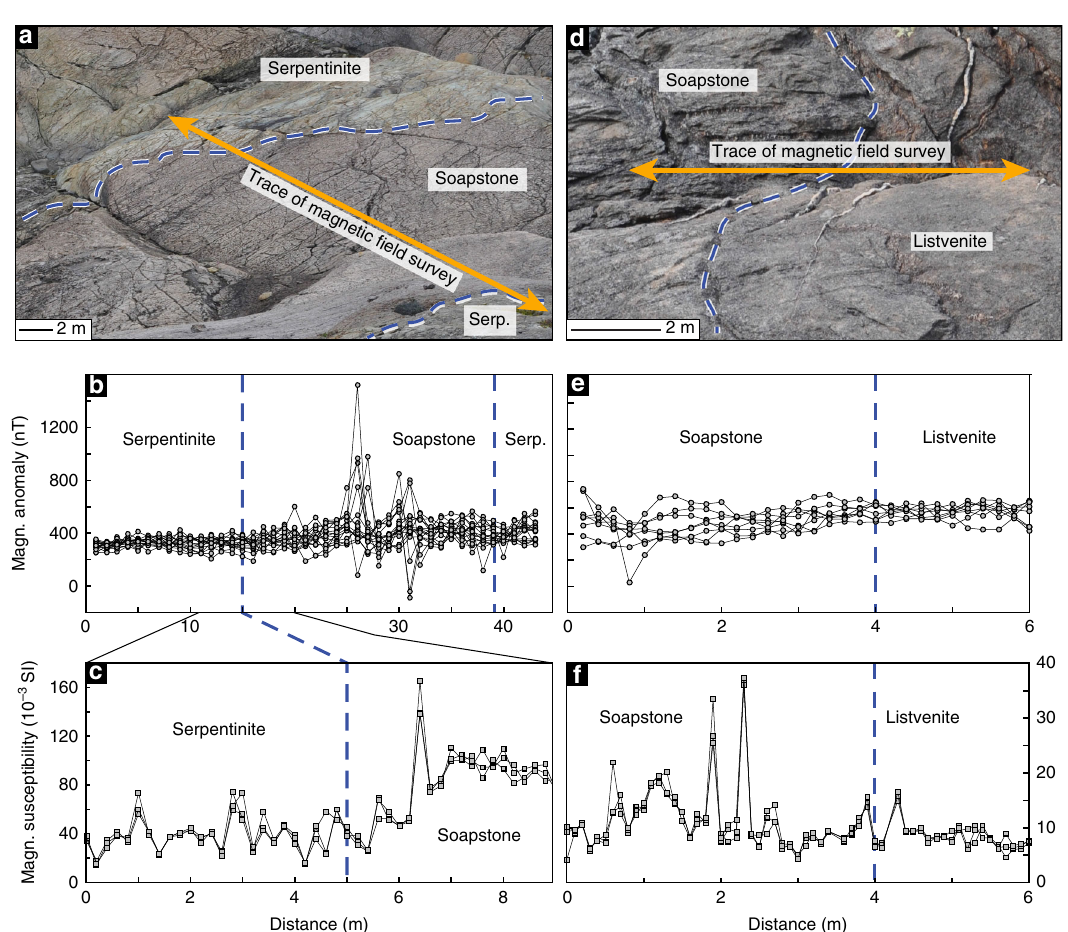
Fig. 6 Outcrop magnetic anomaly measurements. Outcrop scale total fi eld and magnetic susceptibility mapping across the serpentinite-soapstone interface a and the soapstone-listvenite interface d . Total magnetic fi eld values across the serpentinite-soapstone interface were acquired along 16 transects (along the orange line in a ) with a sampling interval and line spacing of 0.6 m and 0.2 m, respectively b . A total of three magnetic susceptibility measurement pro fi les were acquired along a portion of the same transect c . Total magnetic fi eld values across the soapstone-listvenite interface were acquired along 8 transects (along the orange line in d ) with a sampling interval and line spacing of 0.2 m e . A total of three magnetic susceptibility measurement pro fi les were acquired along the same transect